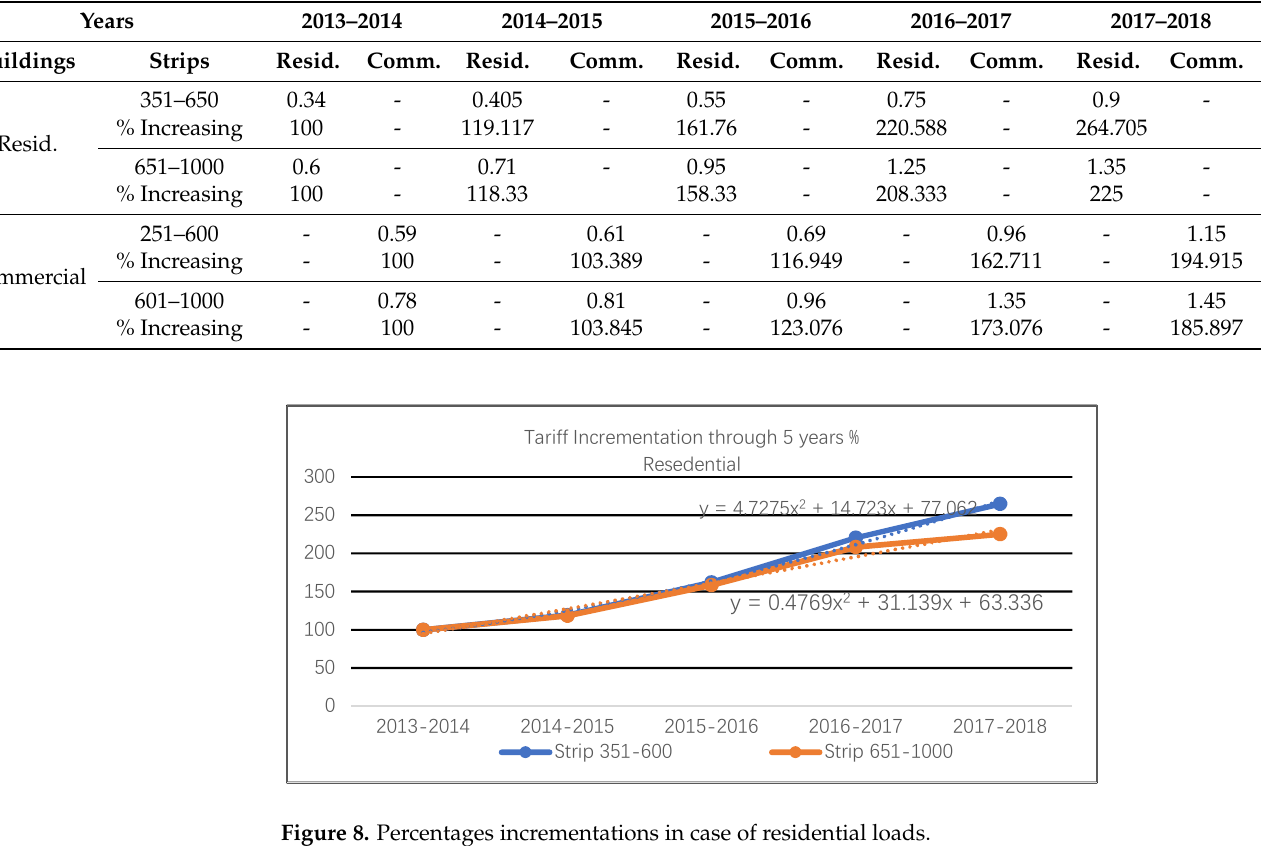
Table 6. Development of Egyptian Ministry of electricity tariff, E£/kWh (2013–2018) (increasing related to 2013–2014 for each range) [72,73].